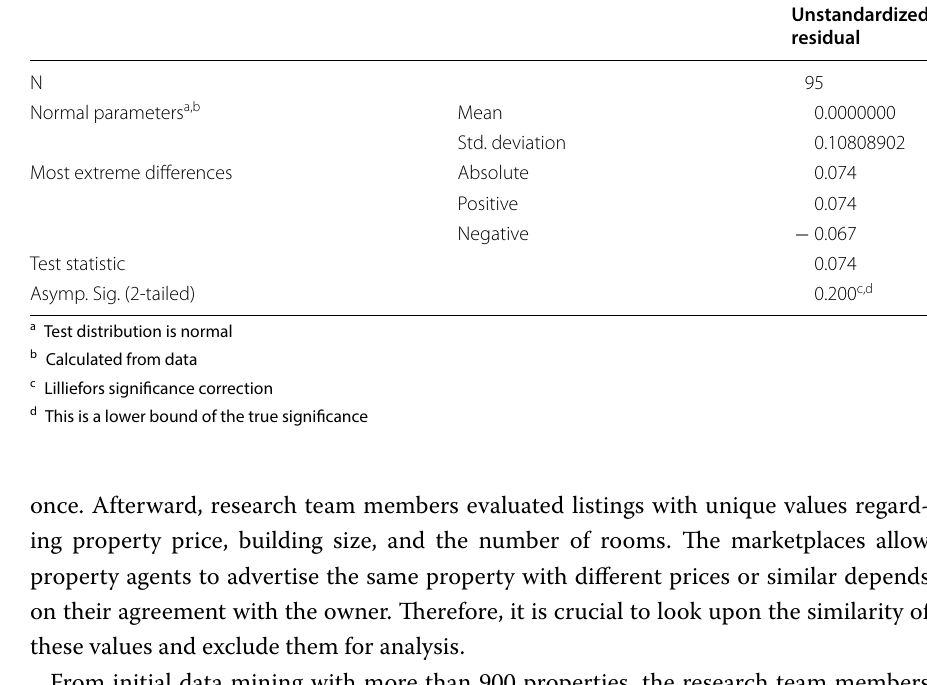
Table 3 One-sample Kolmogorov–Smirnov test